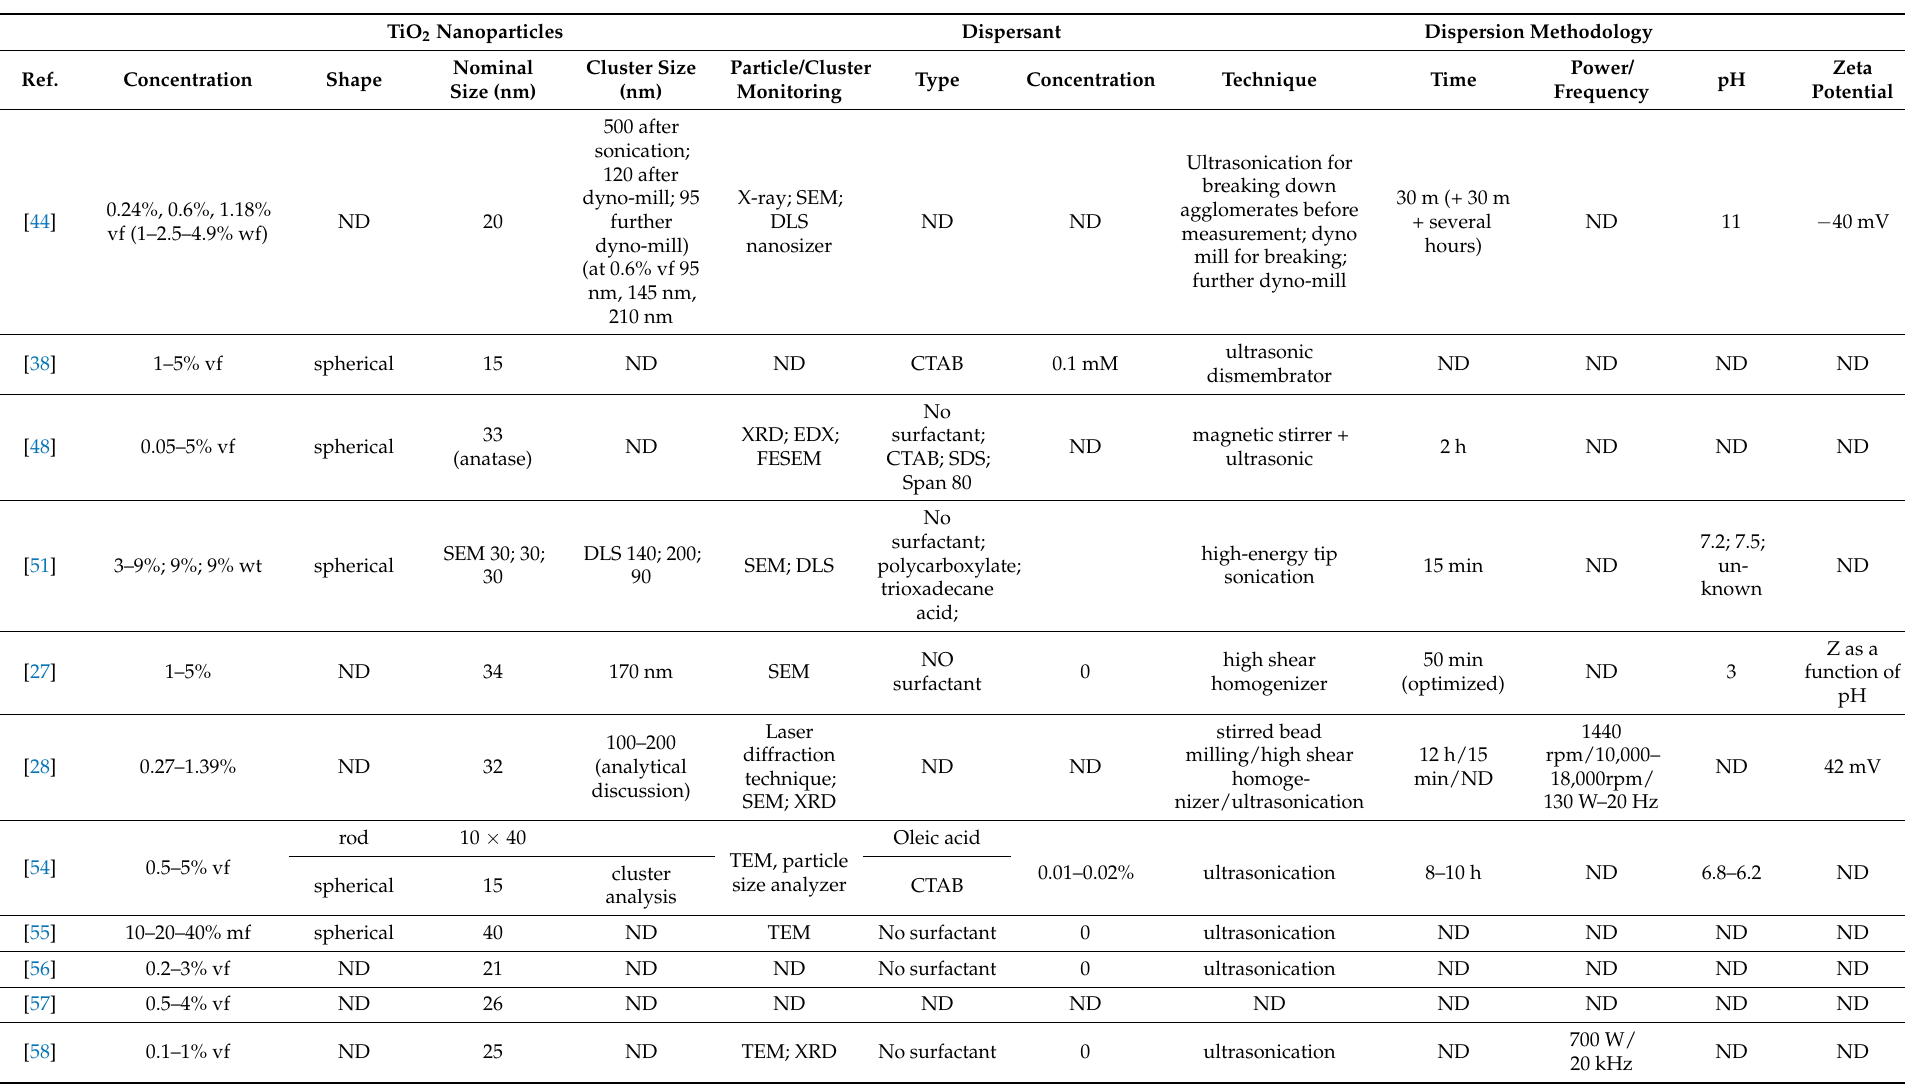
Table 1. Information available in the literature on the preparation parameters for the TiO 2 -water nanofluids. TiO 2 Nanoparticles Dispersant